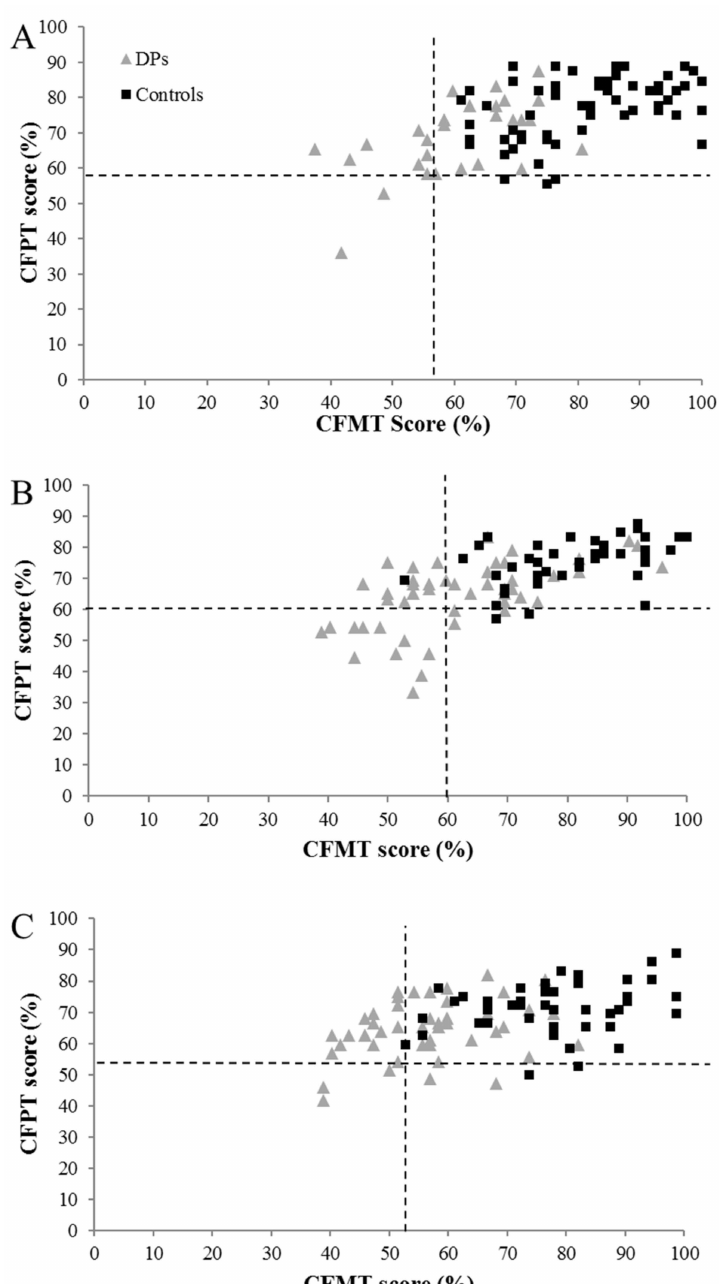
Figure 1. Relationship between CFMT and CFPT scores in the self-referred DP and control groups, for ( A ) 18–34 year olds, ( B ) 35–49 year olds, and ( C ) 50–59 year olds (those aged over 60 years are not displayed as more varied performance prohibits interpretation). Dotted lines represent two SDs from the control